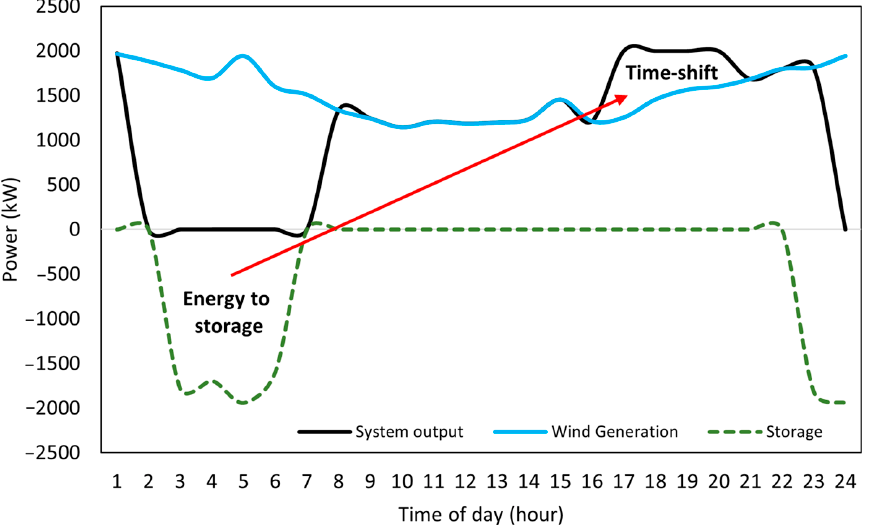
Figure 3. Energy time-shift application example.